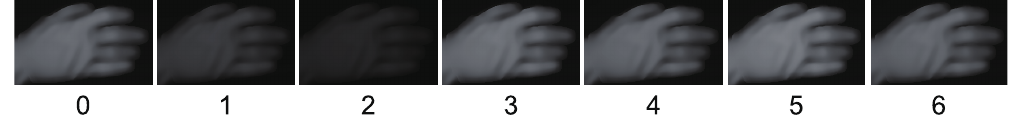
Figure 29. The results for hand with glove. Estimated albedo [pose 2] is shown, which is smooth